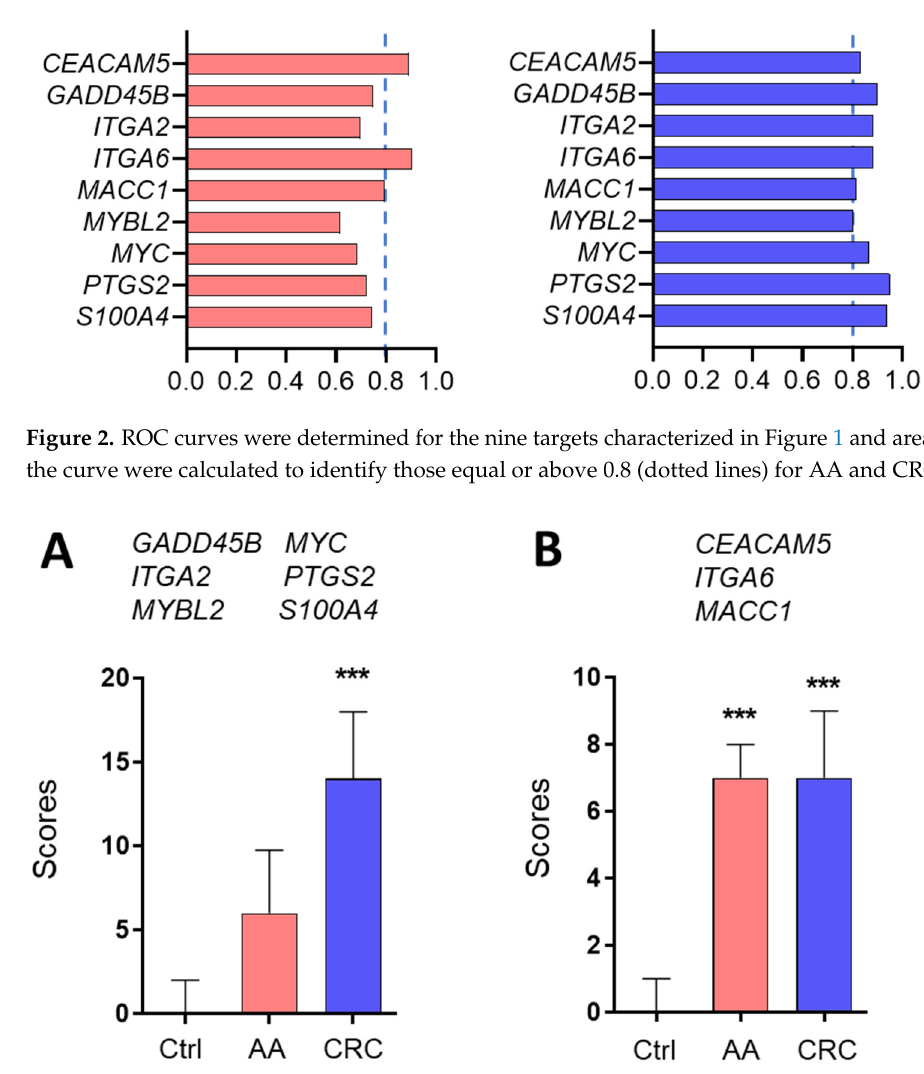
Figure 3. Based on the data from Figures 1 and 2, scores were calculated for the two groups of markers using an algorithm for combining the six targets significant for CRC ( A ) and the three targets significant for AA and CRC ( B ) lesions relative to controls. Results are expressed as median (interquartile range) of scores relative to control patients. *** p < 0.0005 using the Kruskal–Wallis